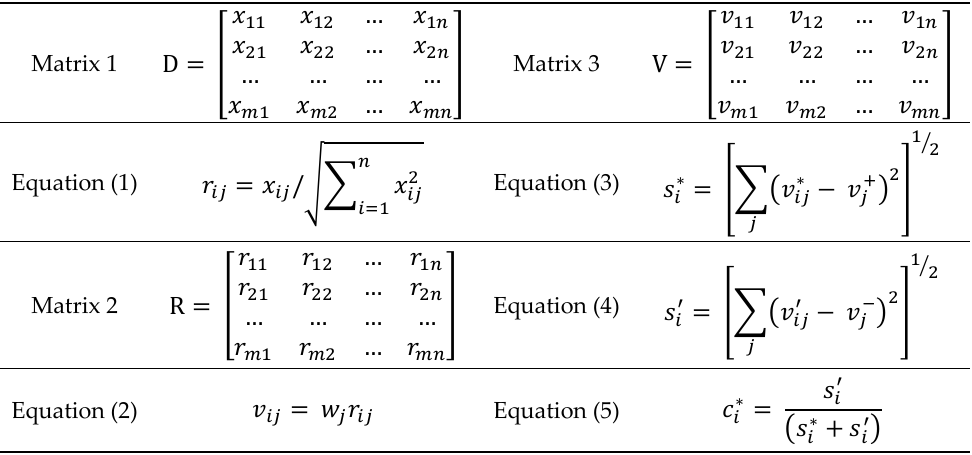
Figure 1. TOPSIS